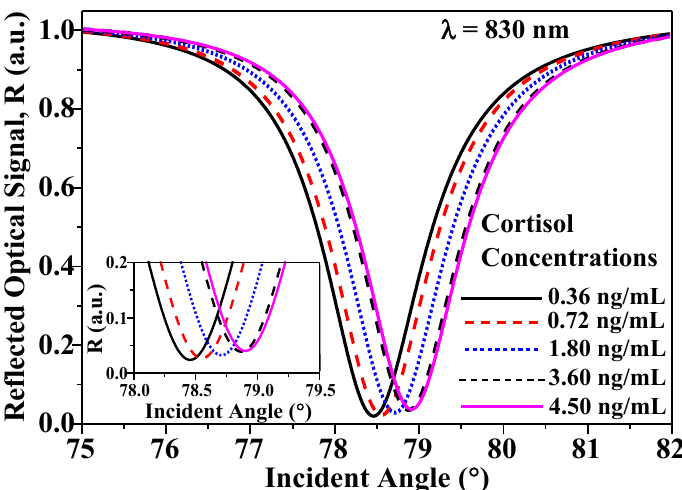
Figure 3. SPR curves for different cortisol concentrations in saliva. The inset shows the enlarged view between the incident angle 78 and 79.5° .